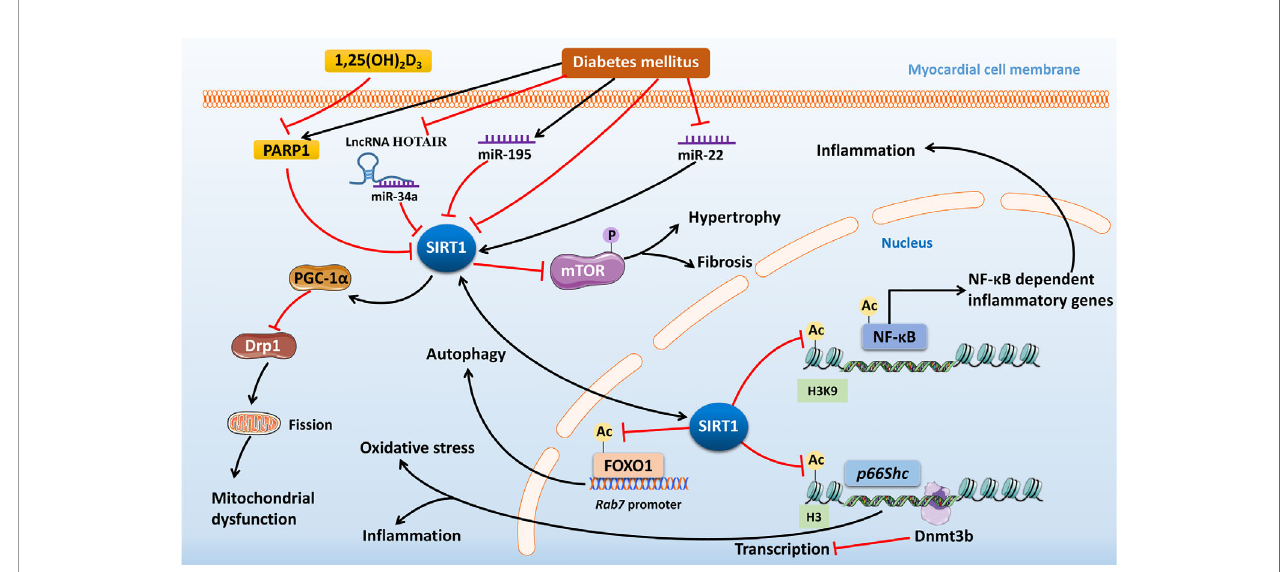
FIGURE 1 | The mechanisms of action and signaling pathways of SIRT1 in diabetic cardiomyopathy. Diabetes mellitus (DM) can inhibit SIRT1 expression by increased expression of PARP1, miR-34a, and miR-195, or by decreased expression of miR-22. SIRT1 can deacetylate NF- k B and H3K9 to inhibit the expression of NF- k B-dependent in fl ammatory genes, which improves DCM. Dysregulation of Dnmt3b and SIRT1 by DM leads to CpG demethylation and histone H3 acetylation at the p66Shc promoter, which can result in sustained transcription of p66Shc to cause cardiac oxidative stress and in fl ammation. SIRT1 can reduce Drp1-mediated mitochondrial fi ssion to exert its cardioprotective role in DCM through increasing PGC-1 a expression. 1,25(OH) 2 D 3 treatment can inhibit PARP1 expression to increase the expression of SIRT1 and repress the phosphorylation of mTOR, thus improving DM-induced cardiac hypertrophy and fi brosis. And SIRT1 can deacetylate FOXO1 and enhance FOXO1 DNA binding at the Rab7 promoter region to ameliorate dysfunctional autophagic fl ux in the hearts of diabetic mice. Finally, lncRNA HOTAIR can upregulate SIRT1 expression by sponging miR-34a to improve DCM. SIRT1, Sirtuin 1; DM, diabetes mellitus; PARP1, poly (ADP-ribose) polymerase 1; miR, microRNA; NF- k B, nuclear factor kappa B; Dnmt3b, DNA methyltransferase 3b; DCM, diabetic cardiomyopathy; Drp1, dynamin-related protein 1; PGC-1 a , peroxisome proliferator-activated receptor gamma coactivator-1 alpha 1,25(OH) 2 D 3, 1,25-Dihydroxyvitamin D3; mTOR, mammalian target of rapamycin; FOXO1, forkhead box O 1; lncRNA HOTAIR, long non-coding RNA HOX transcript antisense